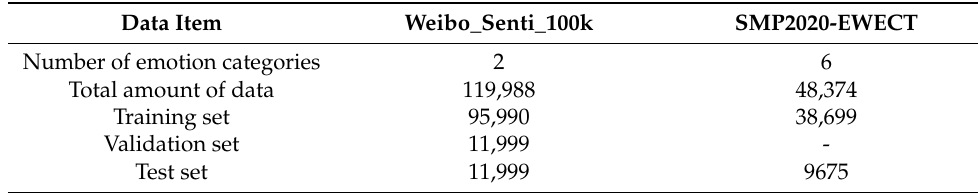
Table 1. Dataset